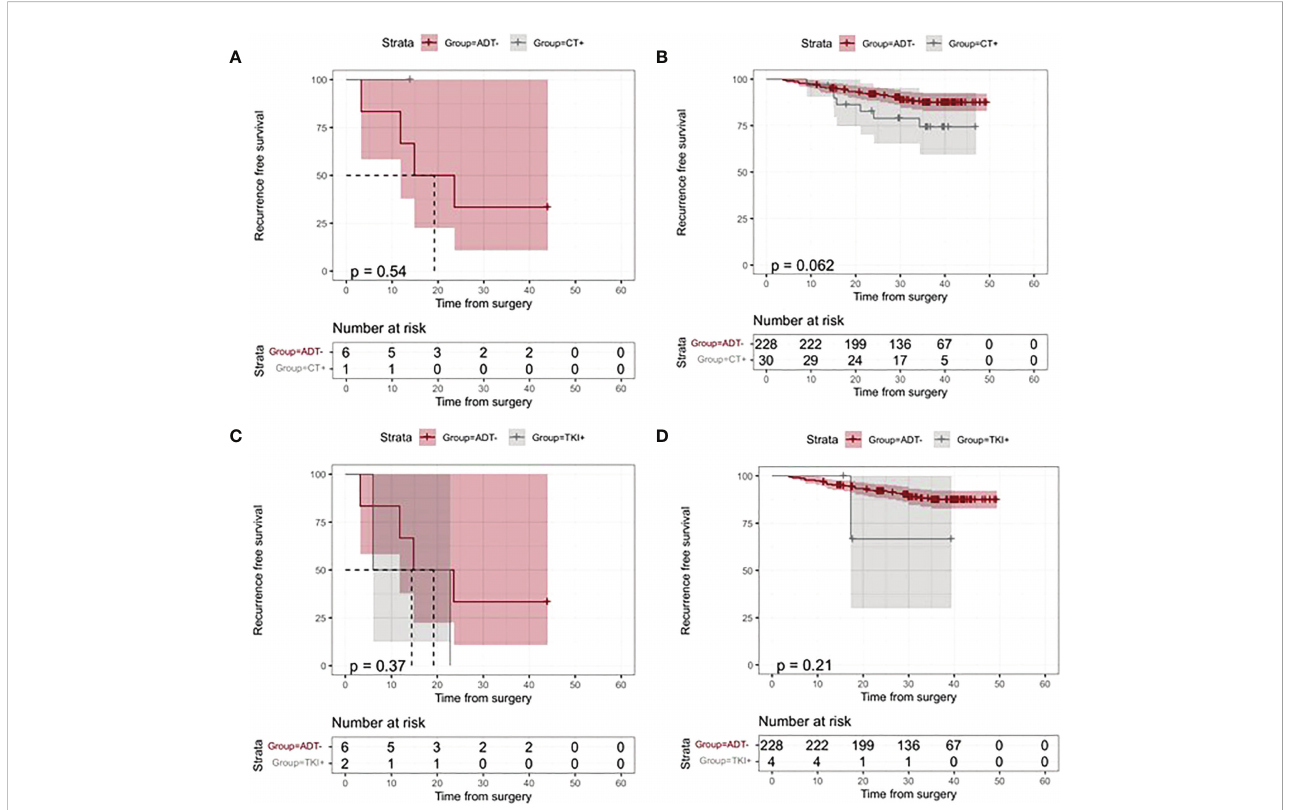
FIGURE 6 Kaplan – Meier analysis of recurrence-free survival (RFS) according to adjuvant treatment modalities and ctDNA status. (A) Kaplan-Meier Curves of RFS for patients who received vs patients who did not receive chemotherapy (CT)-based ADT in the ctDNA-positive group. (B) Kaplan-Meier Curves of RFS for patients who received vs patients who did not receive CT-based ADT in the ctDNA negative group. (C) Kaplan-Meier Curves of RFS for patients who received vs patients who did not receive adjuvant tyrosine kinase inhibitor (TKI) in the ctDNA-positive group. (D) Kaplan-Meier Curves of RFS for patients who received vs patients who did not receive TKI-based ADT in the ctDNA-positive